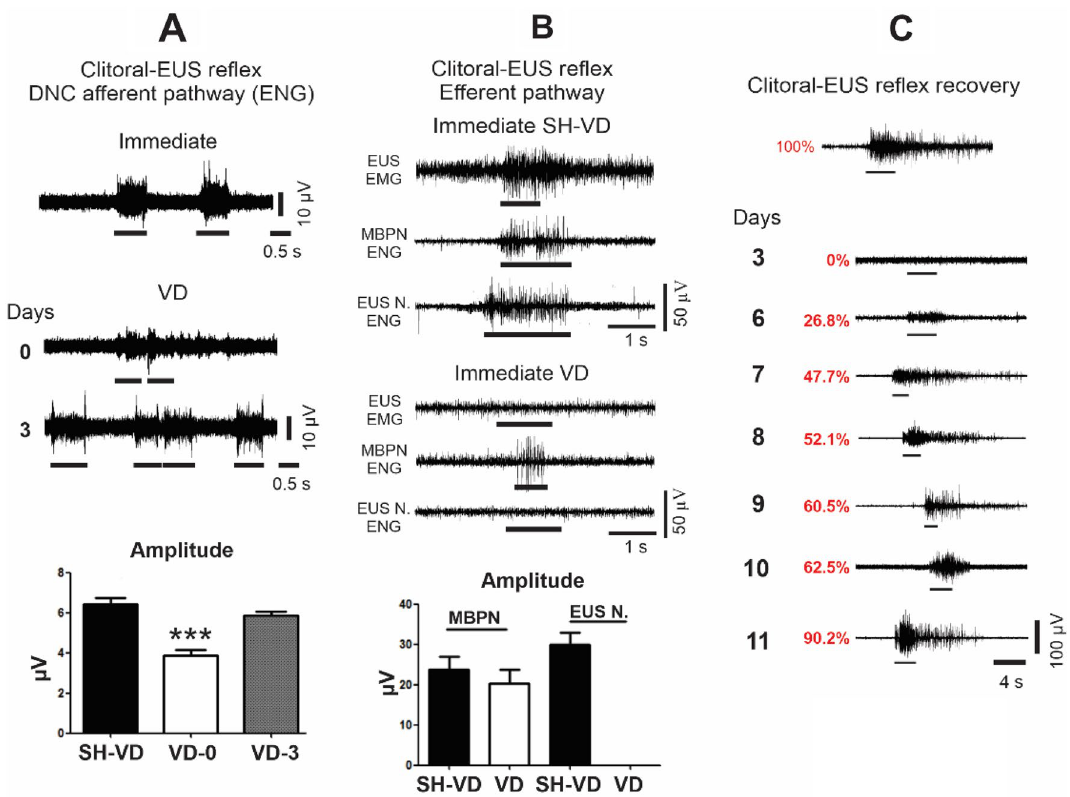
Figure 5. Time course of recovery of the clitoral—external urethral sphincter (EUS) reflex components after vaginal distension (VD) in rats. ( A ) Representative electroneurograms (ENGs) of dorsal nerve of the clitoris (DNC, afferent pathway) immediately and 3 days after VD or sham VD (SH-VD), and graph of the amplitude of DNC activity in SH-VD, immediately, and 3 days after VD. Values are mean ± standard error of the mean. *** ( p < 0.001) indicates significant differences immediately after VD (VD-0) and SH-VD, and 3 days after VD (One Way ANOVA). ( B ) Representative electromyograms of the external urethral sphincter (EUS EMG), and electroneurograms of the motor branch of the pudendal nerve (MBPN ENG) and the EUS nerve (EUS N. ENG) recorded during mechanical stimulation of the clitoris, immediately after SH-VD or VD. The lower panel shows a graph of the amplitude of MBPN and EUS N. activity in SH-VD, immediately after SH-VD or VD. Values represent mean ± standard error of the mean. ( C ) Representative electromyograms of the external urethral sphincter in SH-VD animals, and at 3, 6, 7, 8, 9, 10 and 11 days after